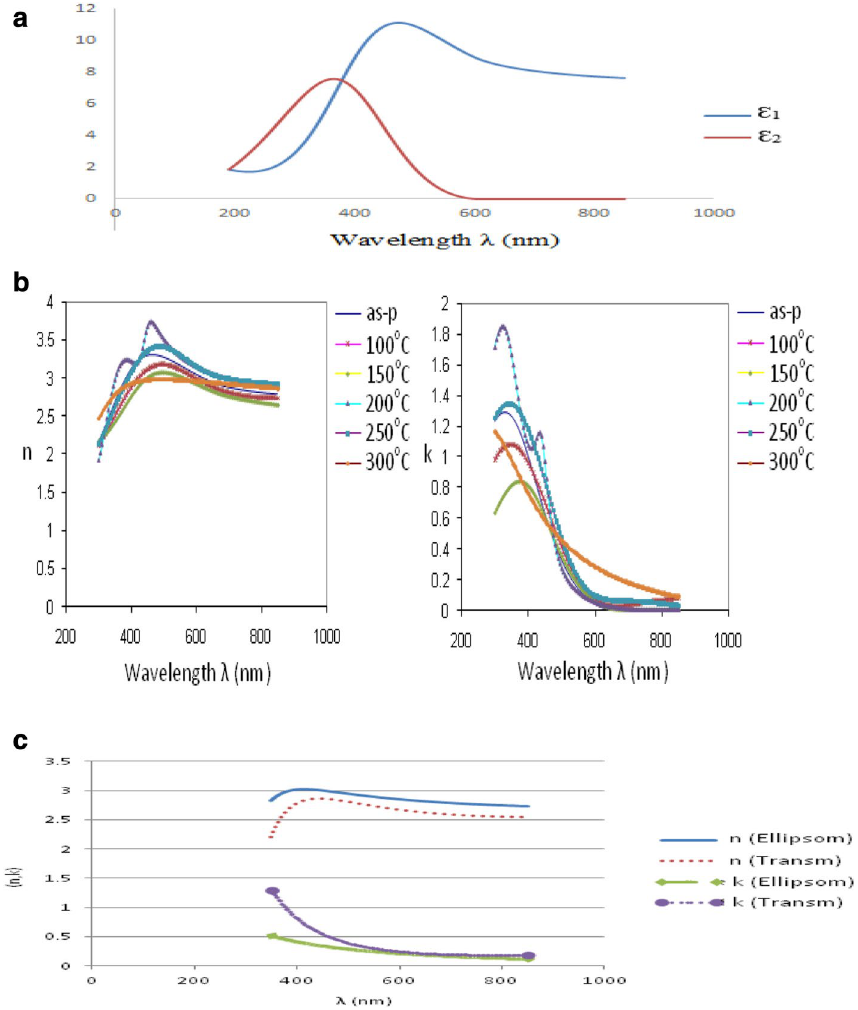
Figure 2. A typical plot of the dielectric constants real (ε 1 ) and imaginary (ε 2 ) parts obtained from reflectance ellipsometry measurement between 190 and 850 nm for the film prepared at 400 W power, 4 sccm oxygen flow rate and 6.0 mTorr pressure. ( b ) Optical constants (n and k) of film as-prepared on glass and silica (200 °C to 300 °C) substrates at the deposition conditions of 600 W-6sccm-6mTorr and annealed at different temperatures. ( c ) Typical plot for comparison of n and k from ellipsometry and optical transmission measurements for the film prepared on glass substrate at 200 W power (0.6 W/cm 2 ), 2sccm oxygen flow and 3.0mTorr